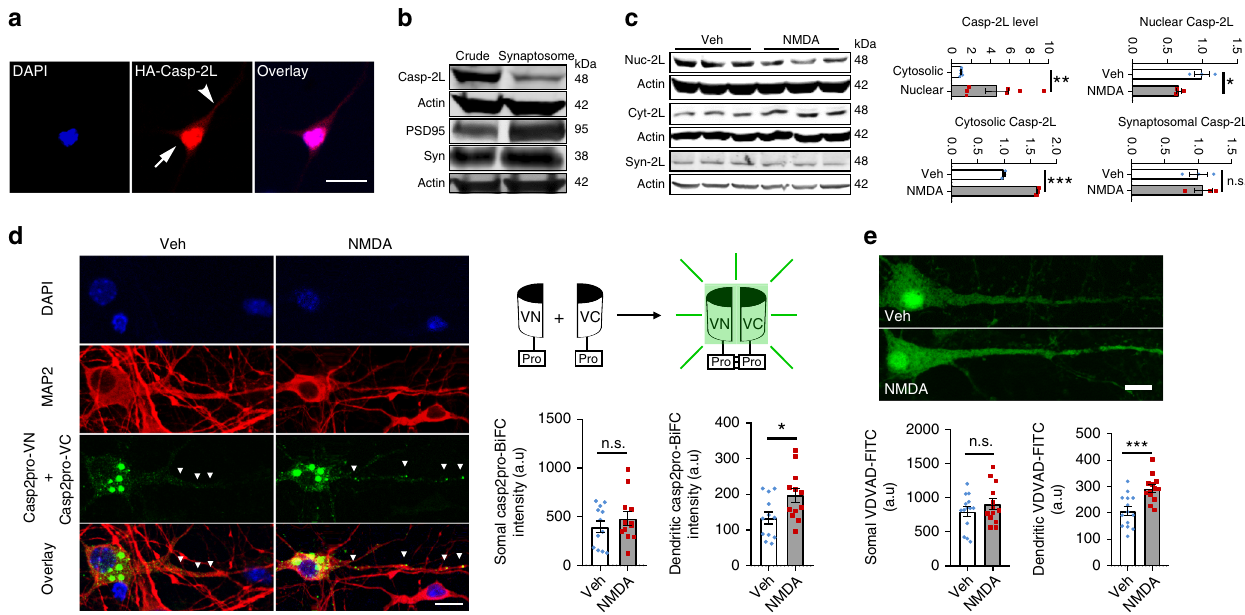
Fig. 2 Neuronal activity alters subcellular localization of caspase-2. a Localization of caspase-2 to the nucleus and dendrites in neurons. Cultured rat hippocampal neurons were transfected with a construct expressing long-form caspase-2 tagged with HA at N terminus (HA-Casp-2L). The arrow and arrow head denote caspase-2 signals in the nucleus and dendrite, respectively. Scale bar, 10 μ m. b Long-form caspase-2 (Casp-2L) is present in synaptosomes isolated from adult mouse brains. PSD95 and synaptophysin (Syn) are enriched in synaptosomes. c Subcellular redistribution of long-form caspase-2 in cultured mouse cortical neurons after NMDA treatment. Actin was used as internal loading control. Sample size: n = 7 for cytoplasm vs. nucleus comparison, n = 3 each for nuclear Casp-2L (Nuc-2L) after vehicle or NMDA treatment, n = 3 each for cytosolic Casp-2L (Cyt-2L) after vehicle or NMDA treatment, and n = 3 each for synaptosomal Casp-2L (Syn-2L) after vehicle or NMDA treatment. d NMDA-induced increase in caspase-2 dimerization in dendrites but not in the soma as revealed through pCasp2pro-VN and pCasp2pro-VC co-transfection. Veh, n = 12 neurons; NMDA, n = 12 neurons. e NMDA-induced increase in caspase-2 activity in dendrites but not in the soma as revealed through in situ measurement with VDVAD-FITC. Veh, n = 14 neurons; NMDA, n = 13 neurons. Data are expressed as mean ± SEM. Two-tailed Student ’ s t test: n.s. no signi fi cance, * p < 0.05, ** p < 0.01, and *** p < 0.001. Source data are provided as a Source Data fi